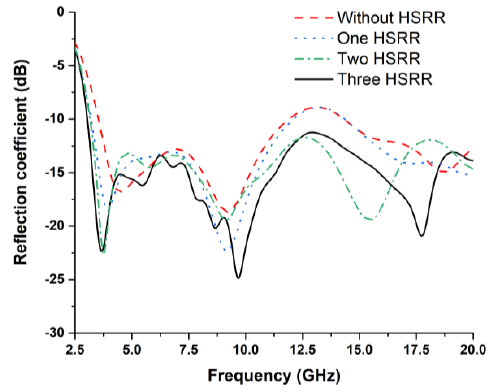
Figure 5. Reflection coefficient of UWB metamaterial antenna without and with HSRR. Sensors 2018 , 18 , x